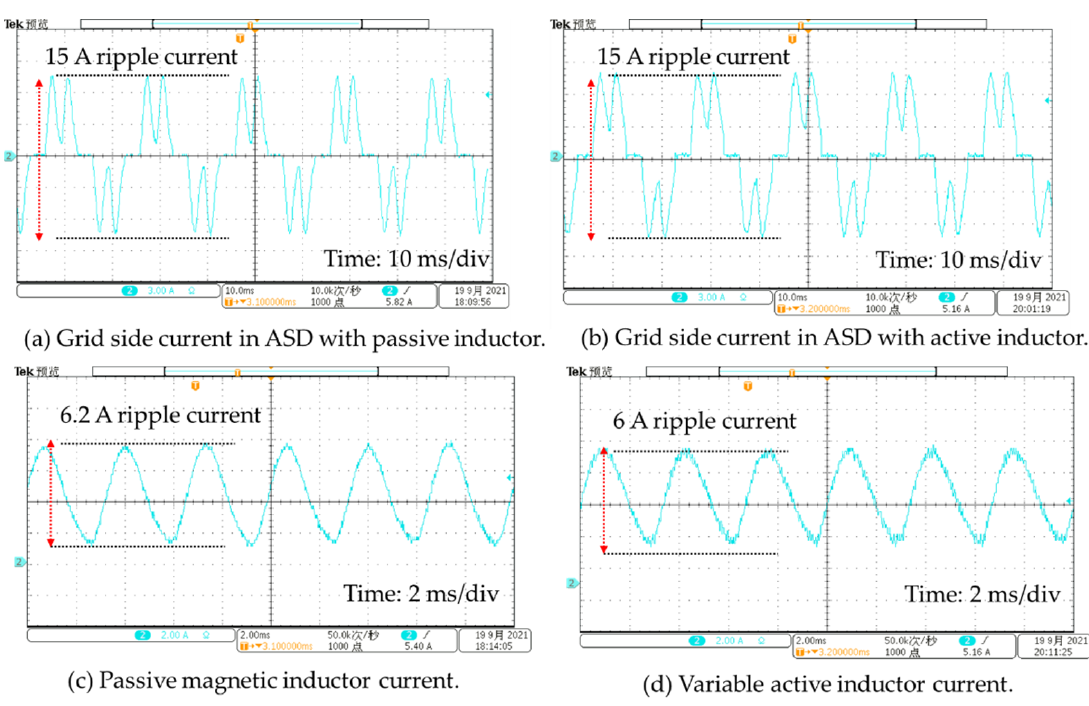
Figure 9. Test results of the passive magnetic inductor and variable active inductor under the un- balanced grid voltage condition in ASD system. ( a ) Grid side current in ASD with passive inductor; ( b ) Grid side current in ASD with active inductor; ( c ) Passive magnetic inductor current; ( d ) Variable active inductor current.